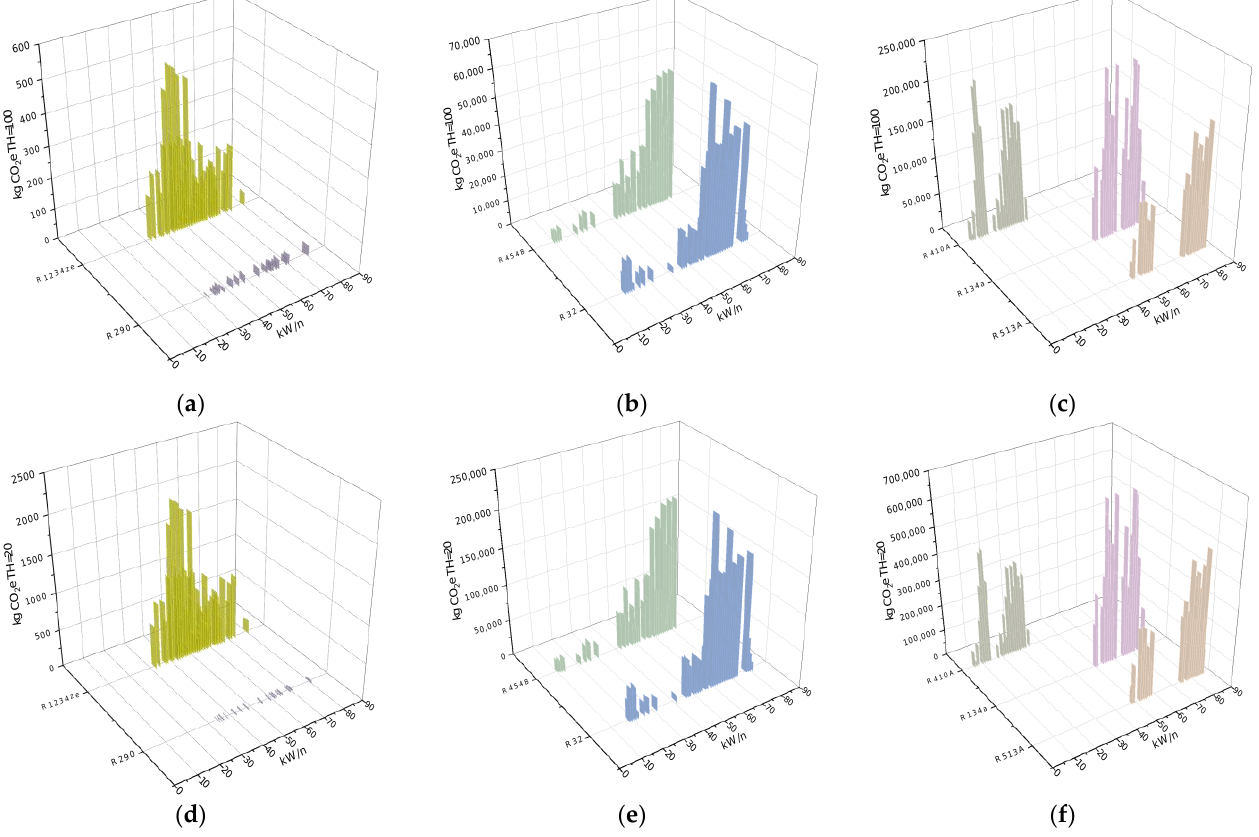
Figure 7. Equivalent of kg CO 2 releases into the atmosphere (for the GWP 100 index); ( a ) GWP 100 index range I, ( b ) GWP 100 index range II, ( c ) GWP 100 index range III, ( d ) GWP 20 index range I, ( e ) GWP 20 index range II, ( f ) GWP 20 index range III.